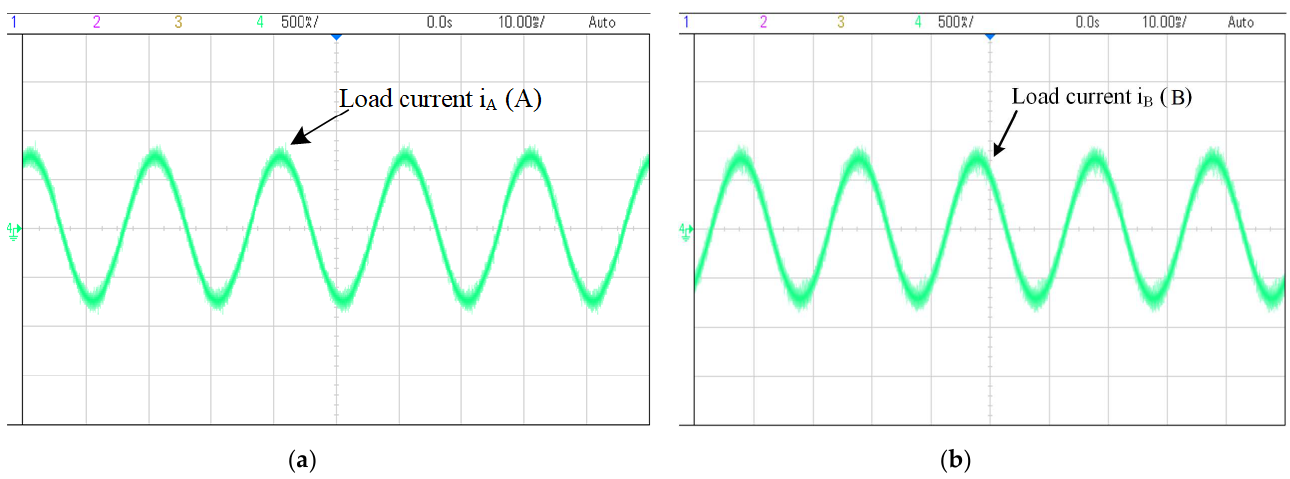
Figure 26. The load current waveforms with an amplitude of 1.7 A and a frequency of 50 Hz for T s = 20 μs measured using Keysight 1146 B current probe: ( a ) Phase “A” load current, ( b ) Phase “B” load current (Scale: Y-axis: 500 mA/div; X-axis: 10 ms/div).